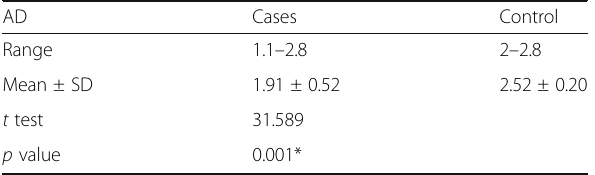
Table 2 Comparison between studied groups according to AD value of optic chiasm ( n = 50) Table 3 Comparison between studied groups according to